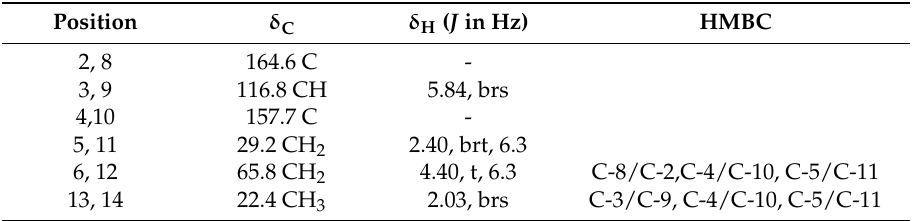
Table 1. NMR data and HMBC correlations for talarodiolide ( 1 ) recorded in CDCl 3 . Position δ C δ H ( J in Hz)